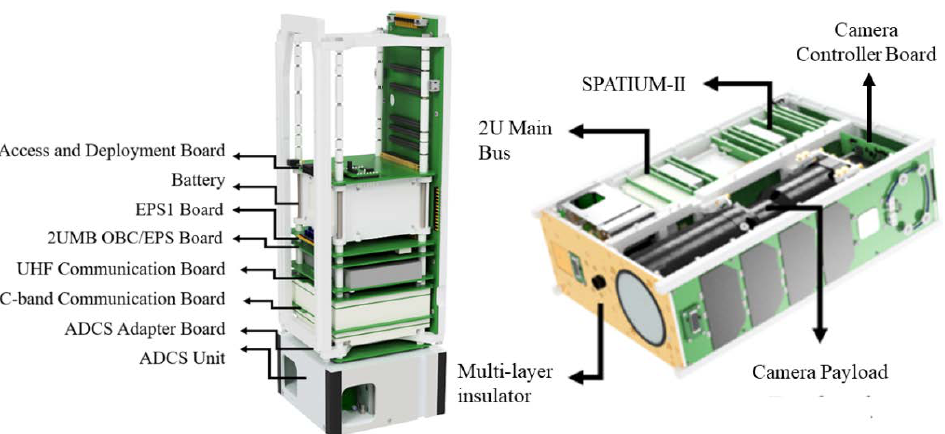
Figure 1. KITSUNE 2U main bus system configuration ( left ) and the satellite overview with 3U imaging payload ( right